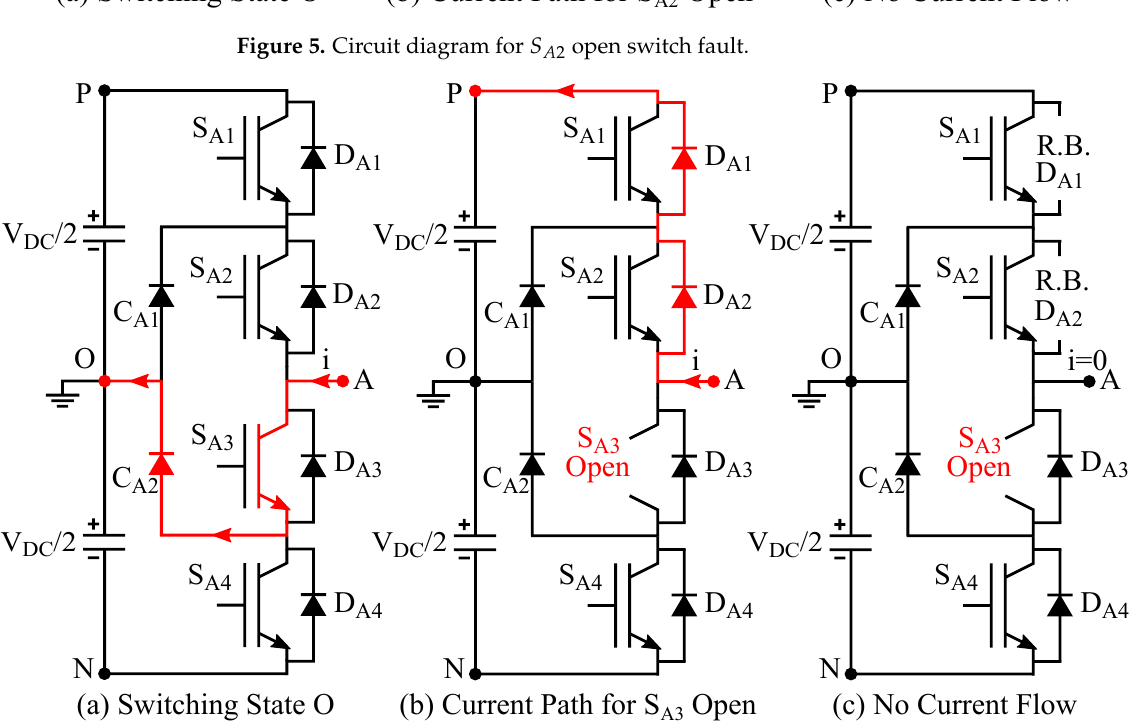
Figure 6. Circuit diagram for S A 3 open switch